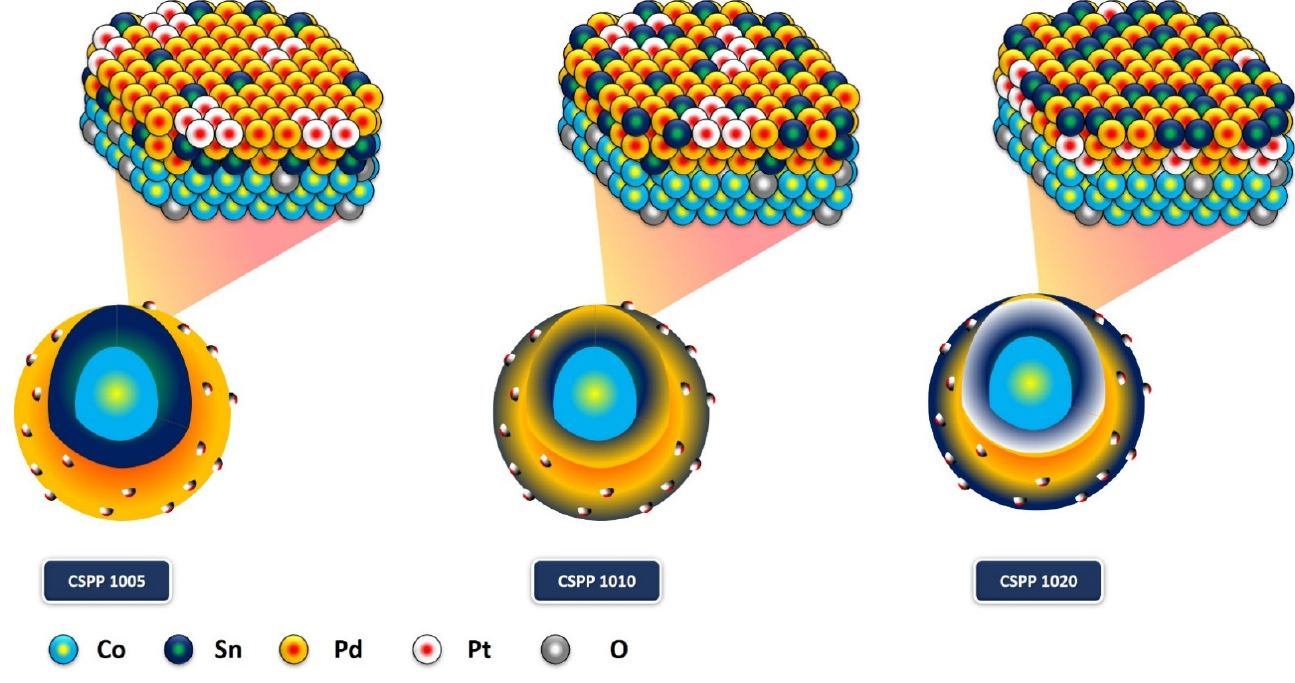
Scheme 1. Schematic illustration of the proposed structure of CSPP